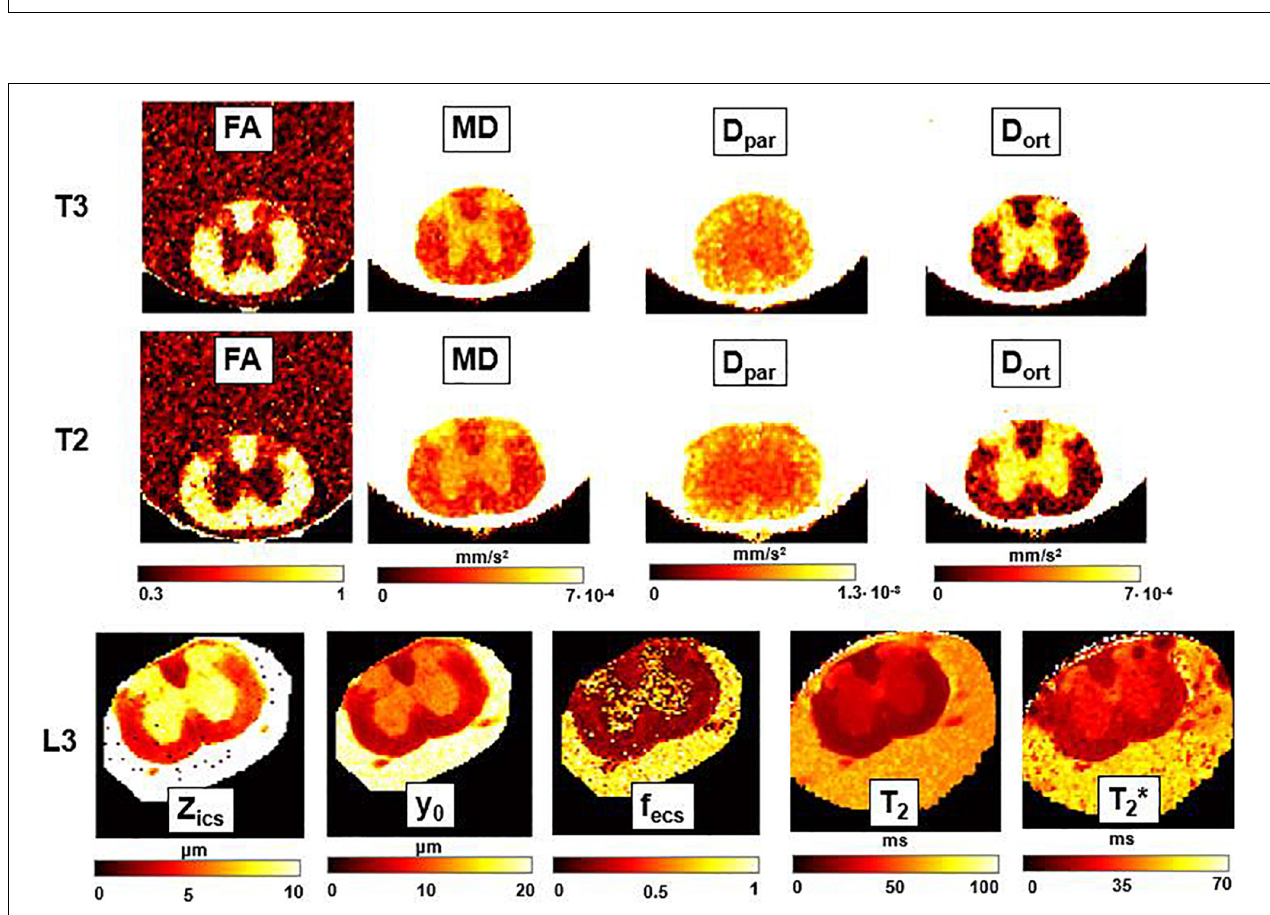
FIGURE 7 | α -imaging parametric maps. Transient subdiffusion maps of thoracic segment at the level T2/T3. Parametric maps of α -anisotropy (A α ), mean- α (M α ), α orthogonal to the WM fibers ( α ort ), and α parallel to the WM fibers ( α par ). α -anisotropy is shown with a different colorbar. The parametric maps are extracted from the axial slices in the thoracic segments T2 (top row) and T3 (bottom).